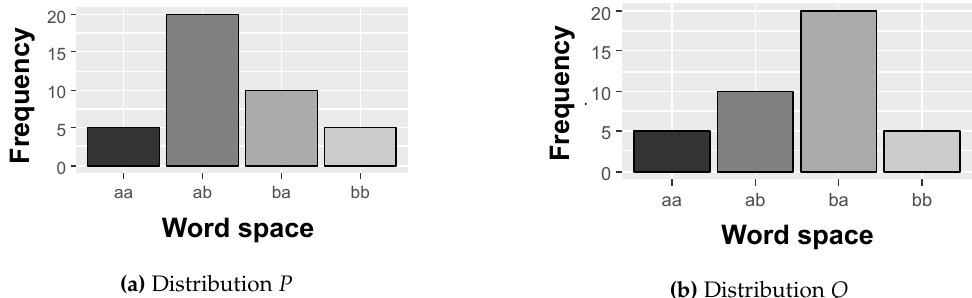
Figure 6. The minimum entropy can be represented by the distribution on the left, where H [ P ] = H min = 0. The uniform distribution P e , right in the figure, also called the uniform histogram ( H ref ), represents a random series in which all occurrences have the same probability value (e.g., a random noise). In the example there are four symbol possibilities, each with probability p = 1